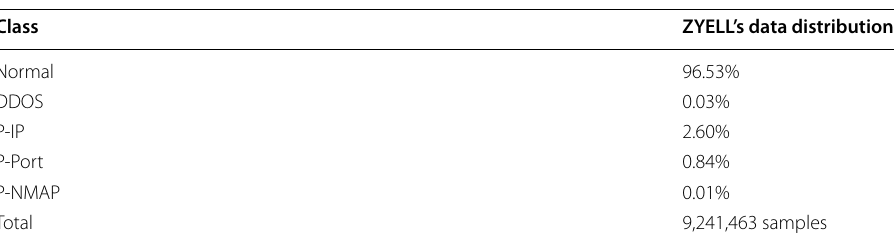
Table 3 Statistics about ZYELL’s training set